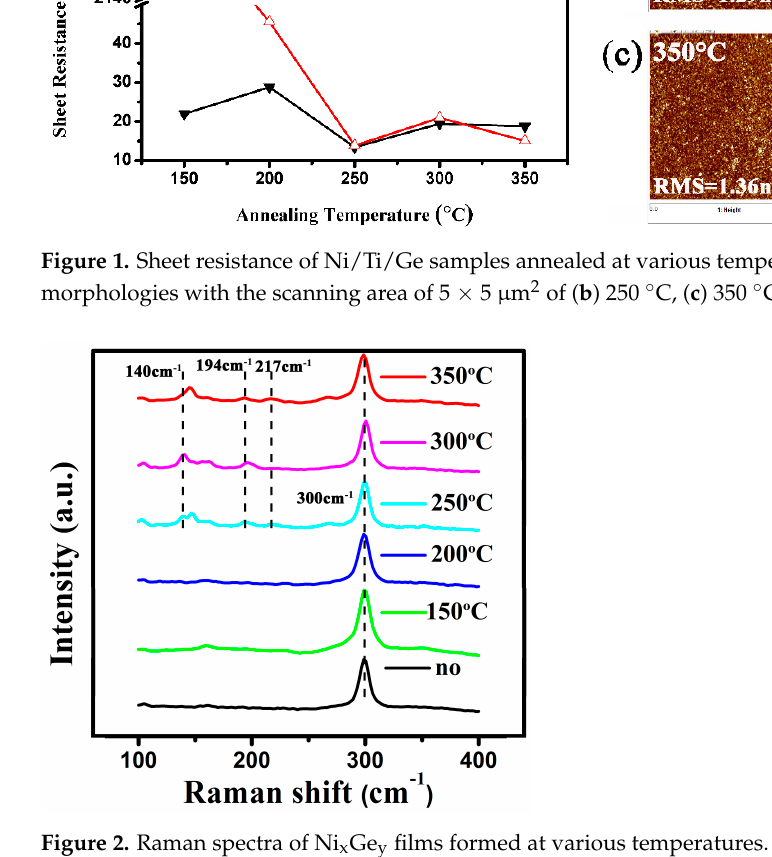
Figure 2. Raman spectra of Ni x Ge y films formed at various temperatures.